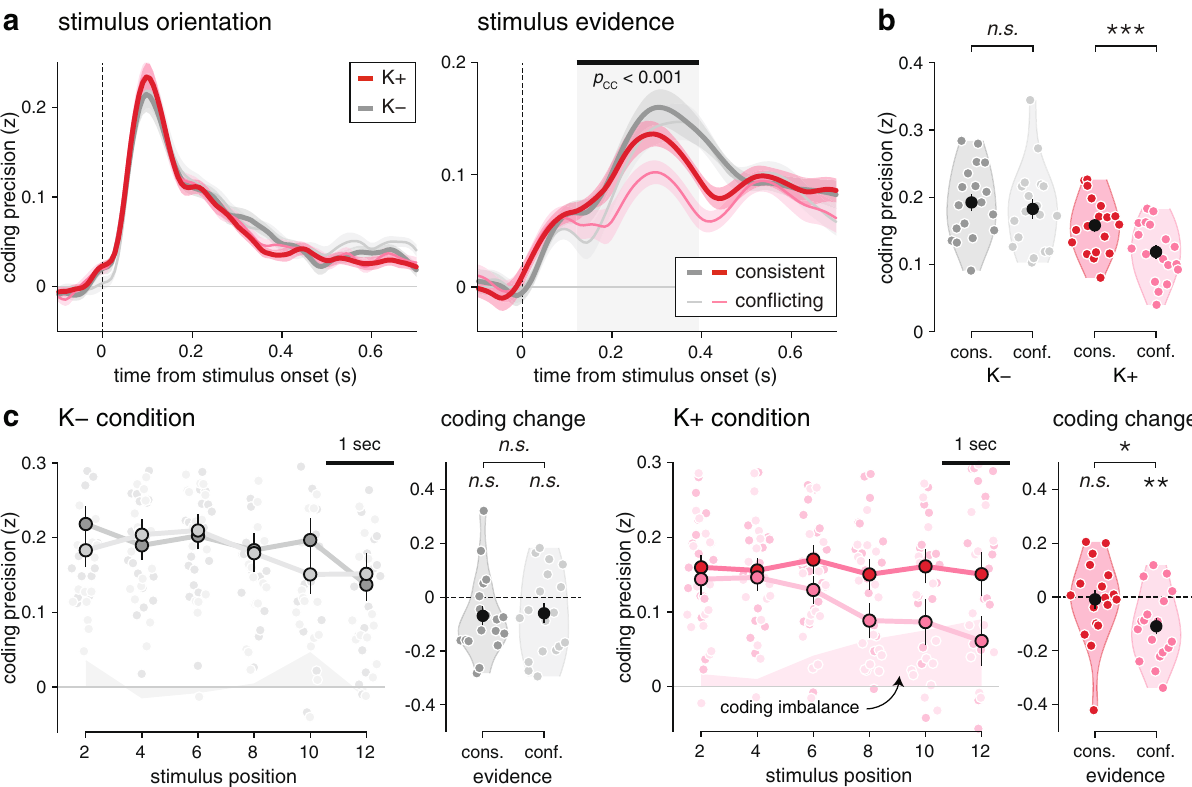
Fig. 5 Unbalanced neural processing of evidence under ketamine. a Effect of decision consistency on the neural coding of stimulus orientation (left) and stimulus evidence (right). Thick lines correspond to stimuli consistent with the upcoming decision, whereas thin lines correspond to stimuli con fl icting with the upcoming decision. The neural coding of stimulus orientation does not differ between consistent and con fl icting stimuli, whereas the neural coding of stimulus evidence is less precise for con fl icting stimuli under ketamine. Lines and shaded error bars indicate group-level means ± s.e.m. ( N = 18 participants). The gray-shaded area indicates the signi fi cant effect of decision consistency on coding precision (two-sided t tests corrected for multiple comparisons across time). b Effect of decision consistency on the neural coding of stimulus evidence in the time window showing a ketamine effect (250 – 450 ms following stimulus onset). Consistent and con fl icting stimuli are coded equally precisely under placebo (left), whereas con fl icting stimuli are coded less precisely under ketamine (right). c Dynamics of coding unbalance under placebo (left) and ketamine (right). Left: coding precision of stimulus evidence as a function of decision consistency and stimulus position in the sequence. Shaded areas indicate the strength of coding unbalance (i.e., the difference in coding precision between consistent and con fl icting stimuli). Right: coding change with stimulus position for consistent and con fl icting stimuli. The neural coding of consistent and con fl icting stimuli is stable over time under placebo, whereas the neural coding of con fl icting stimuli decreases over time under ketamine. One star indicates a signi fi cant effect at p < 0.05, two stars at p < 0.01, three stars at p < 0.001, n.s. a non-signi fi cant effect ( N =